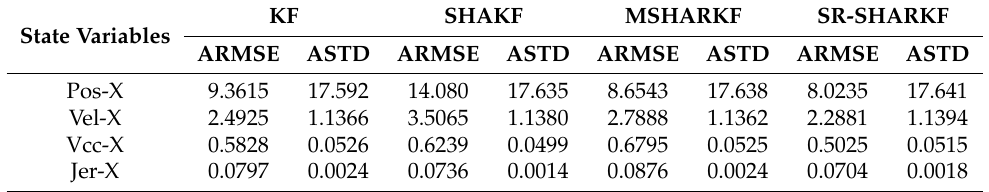
Table 5. Dynamic parameter ARMSE and ASTD evaluation in the X-Axis